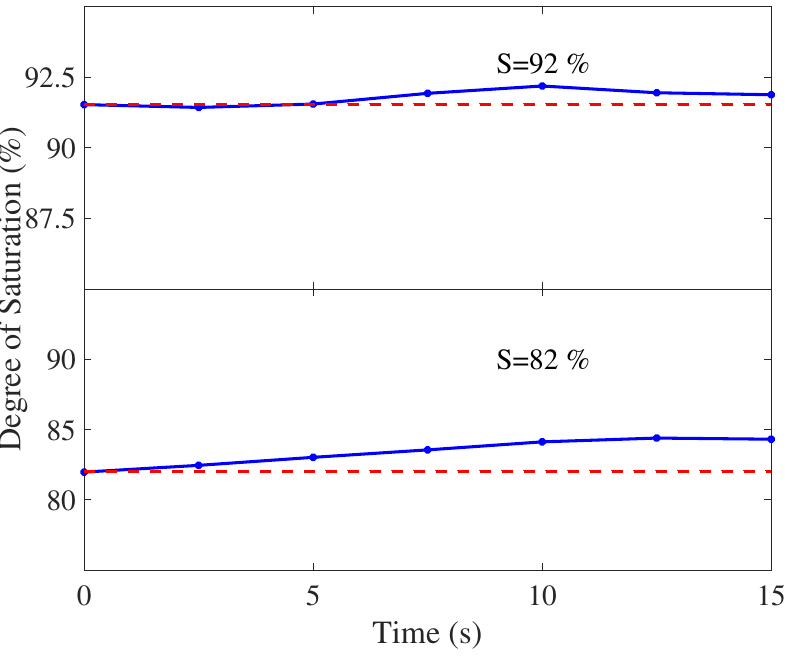
Figure 15. Degree of saturation change during the shaking for desaturated soil deposits (Dashed lines represent the initial degree of saturation of the deposits).